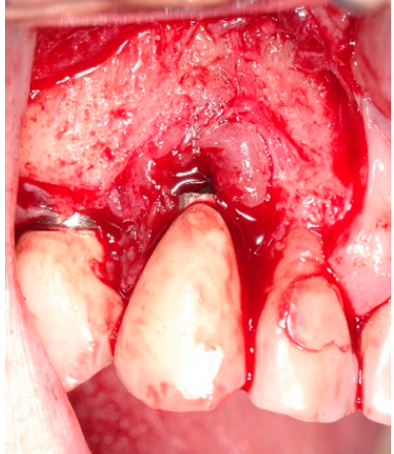
Figure 2. Clinical image showing inflamed tissues around the implant.